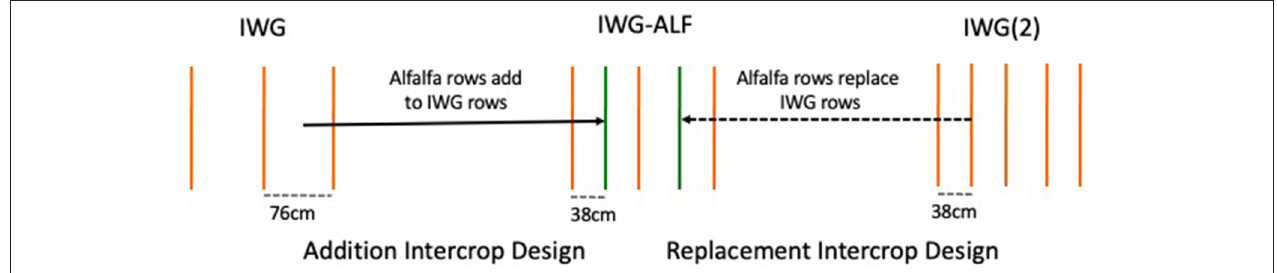
FIGURE 1 | Addition and replacement designs for comparing IWG-ALF intercrops with IWG monocrop